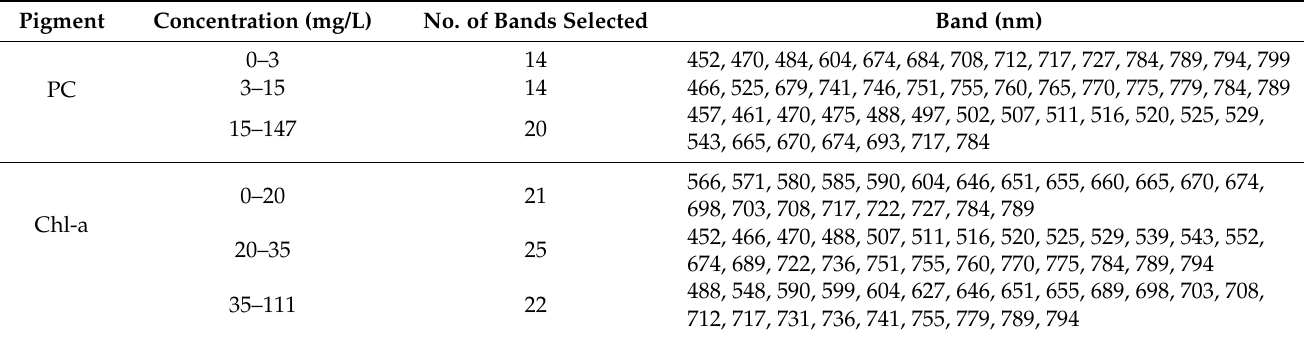
Table 2. Result of band selection according to PC and Chl-a concentration using random forest feature importance.